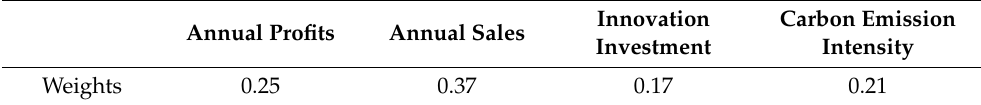
Figure 5. Composition of competitiveness index. Table 1. Weights of individual competitiveness